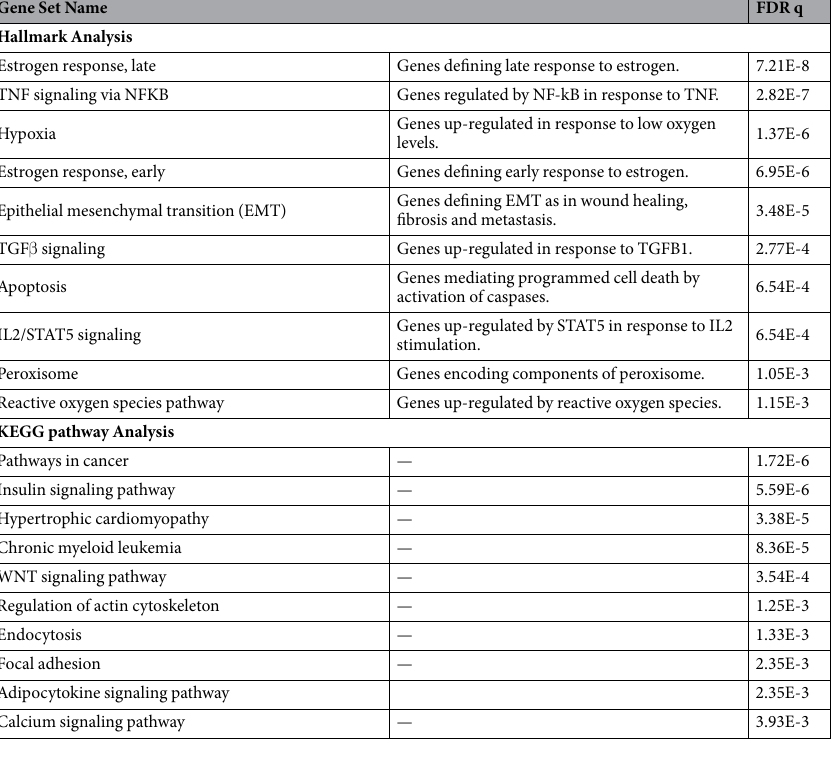
Table 1. Hallmark and KEGG pathway analysis of BAV vs. TAV hypomethylated DMR-associated genes, non- dilated aorta. Age-corrected methylation